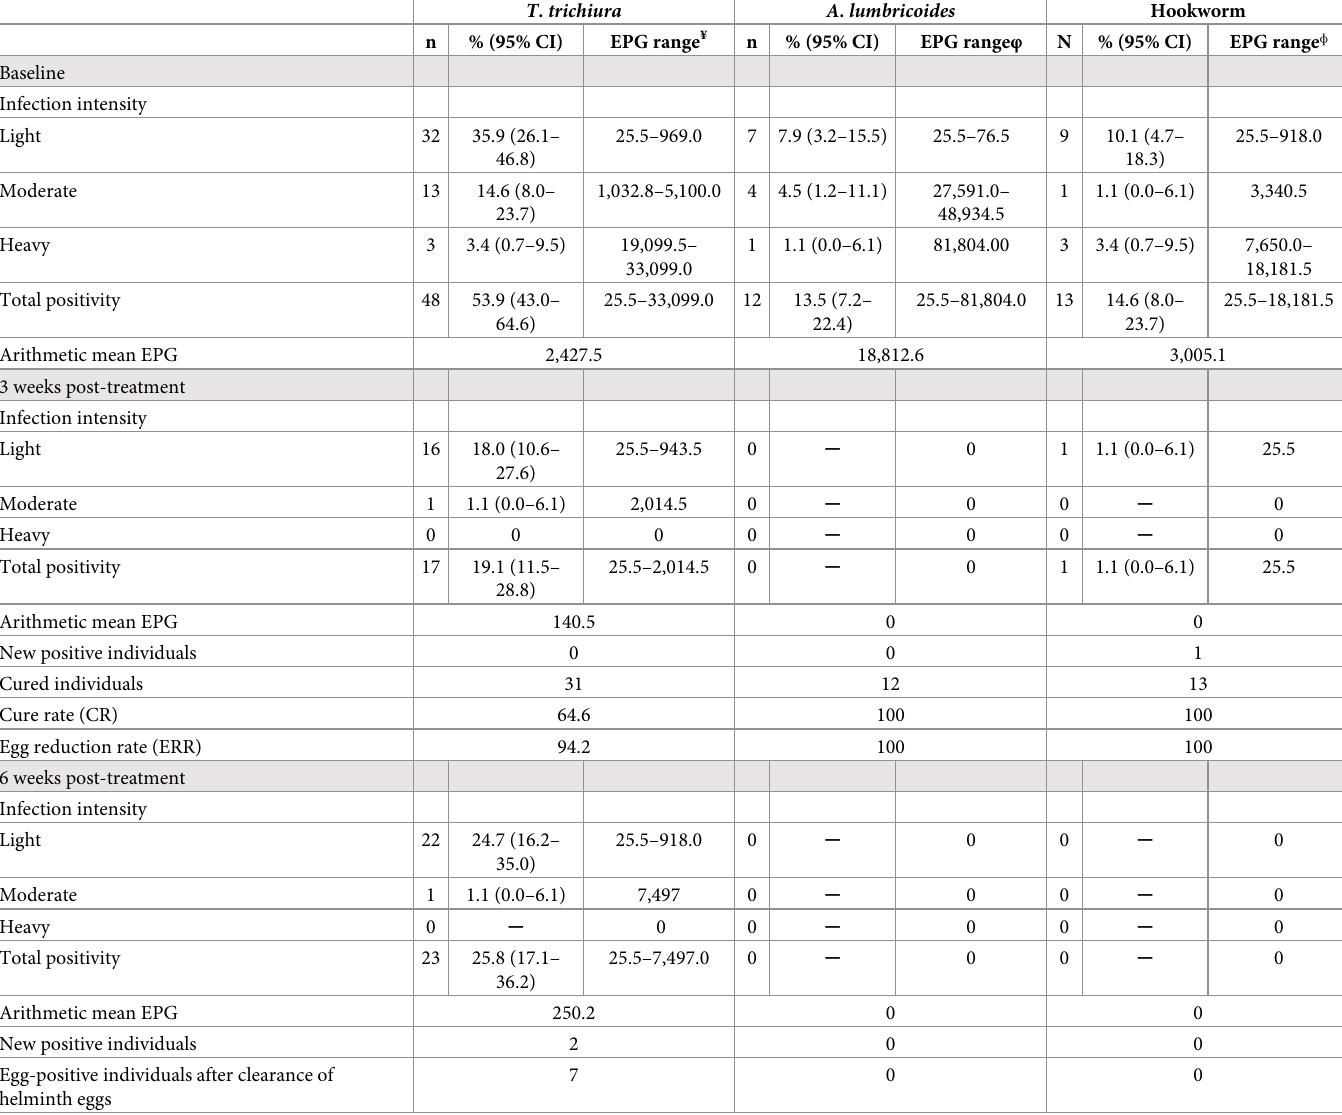
Table 5. Positivity rates, infection intensities, cure rates and egg reduction rates of T . trichiura , A . lumbricoides and hookworm at baseline, 3 weeks post-treatment and 6 weeks post-treatment among who were fully treated with 3 doses of albendazole (N =